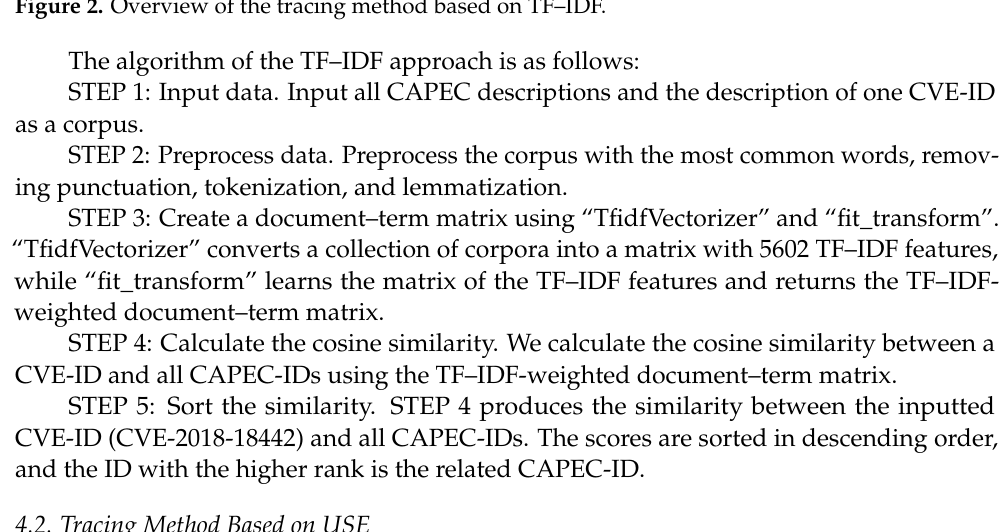
Figure 2. Overview of the tracing method based on